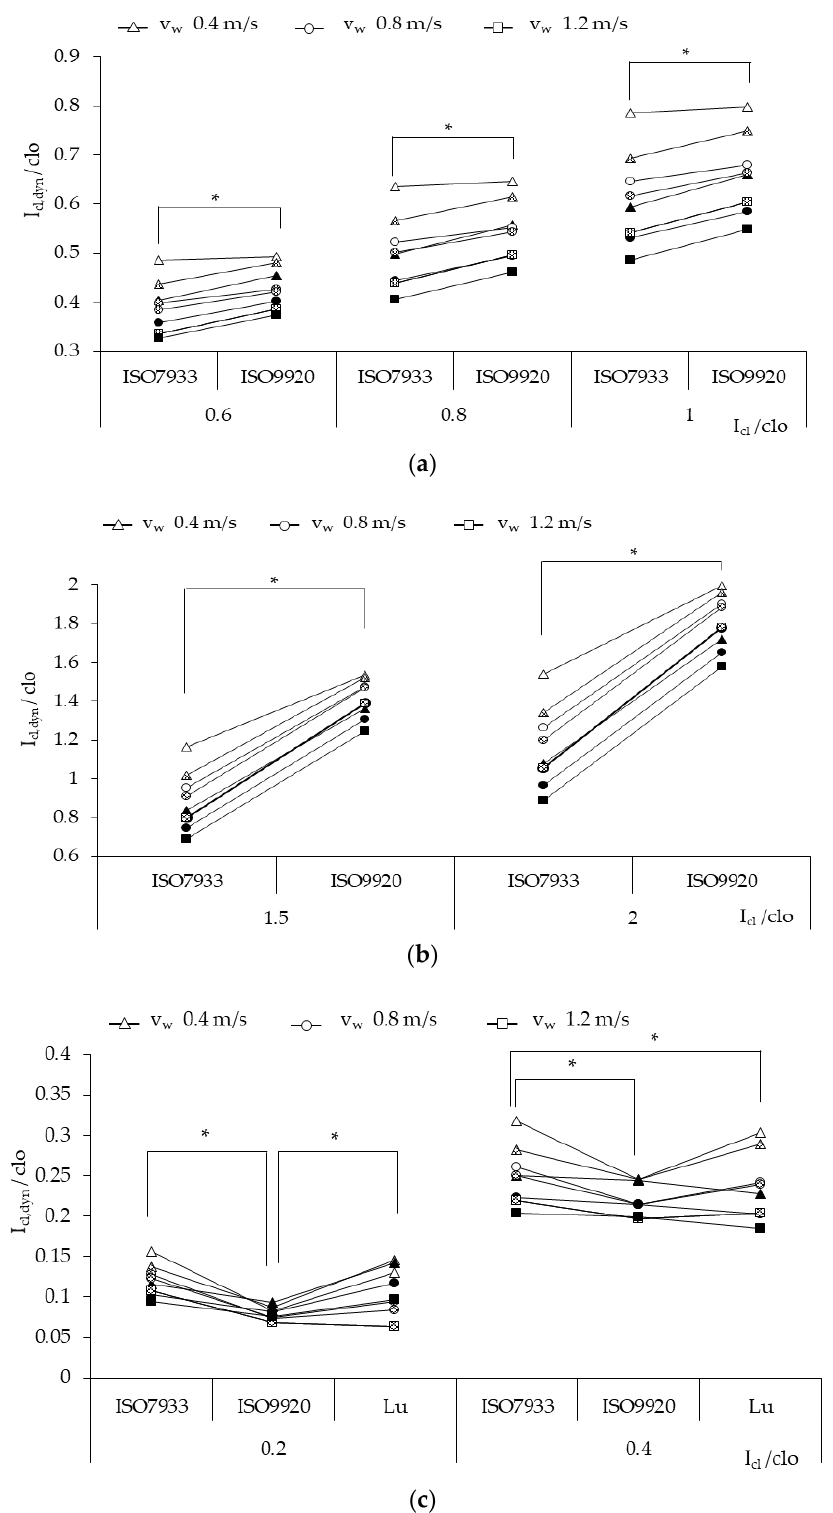
Figure 1. The dynamic clothing insulation of three types of clothing: ( a ) NC, ( b ) SC, ( c ) LC, calculated by three correction algorithms of ISO 7933, ISO 9920, and Lu, with empty spots for v a = 0.5 m / s, partially filled for the v a = 1 m / s, and fully filled for the v a = 3 m / s. * p < 0.05.